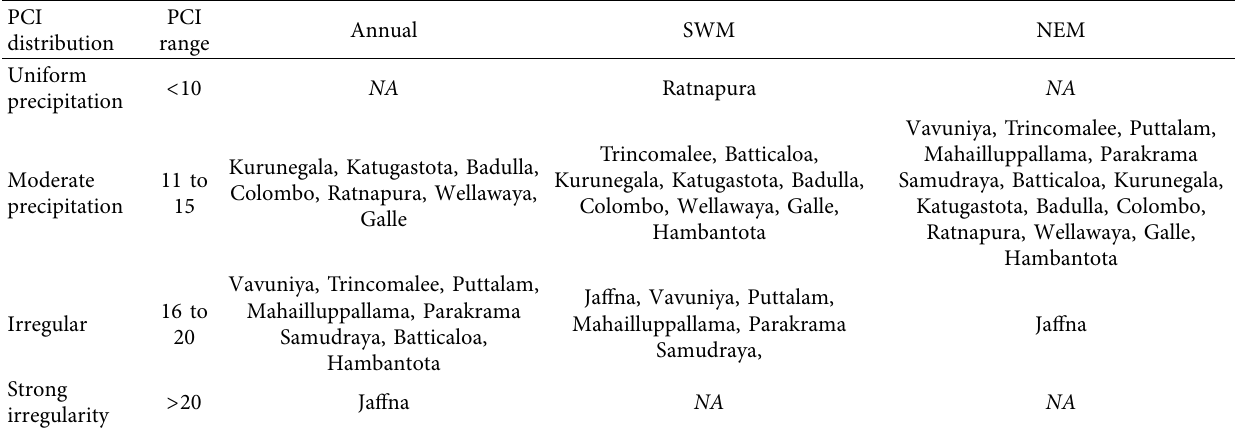
Table 5: PCI distribution.